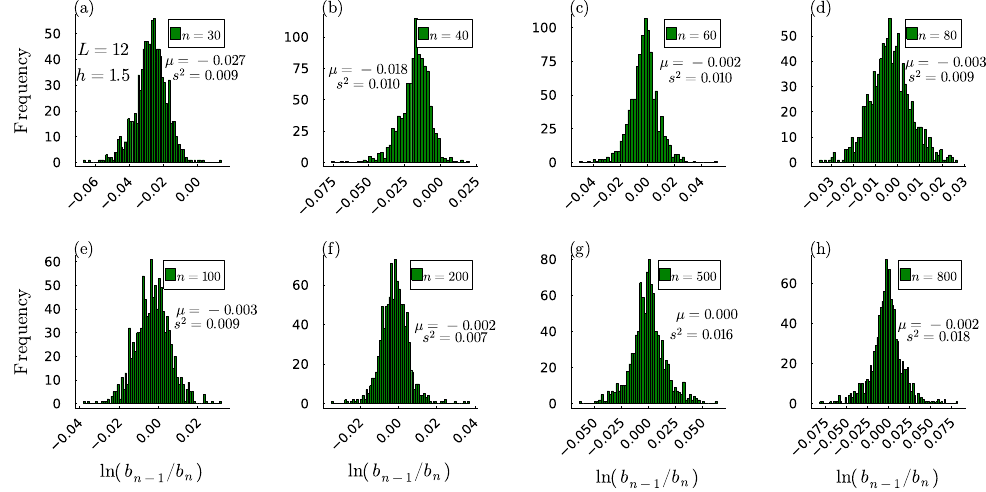
/ b ) for several n , L = 12 and h = 1.5 (er- 2 n − 1 2 n